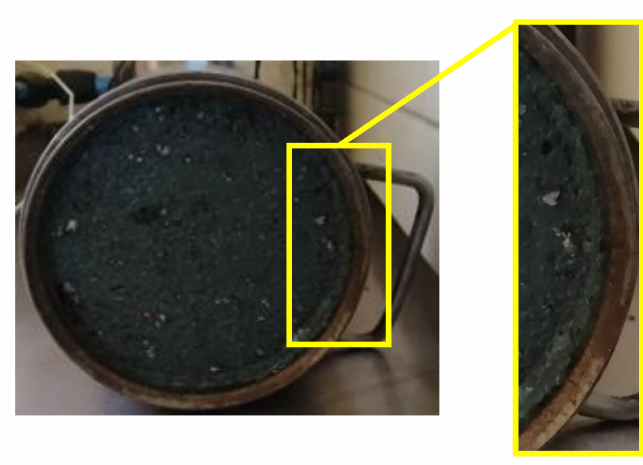
Figure 3. Blue specimen with an excess of bitumen.